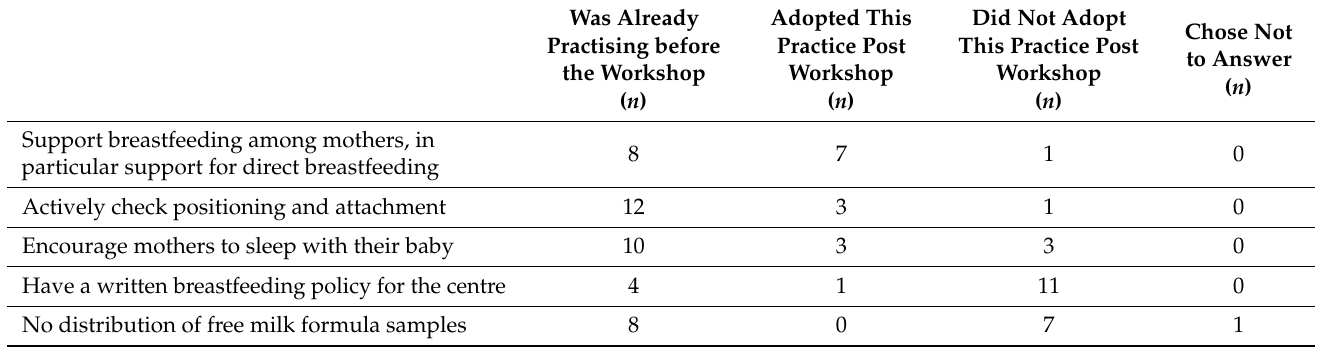
Table A1. Post-workshop interview